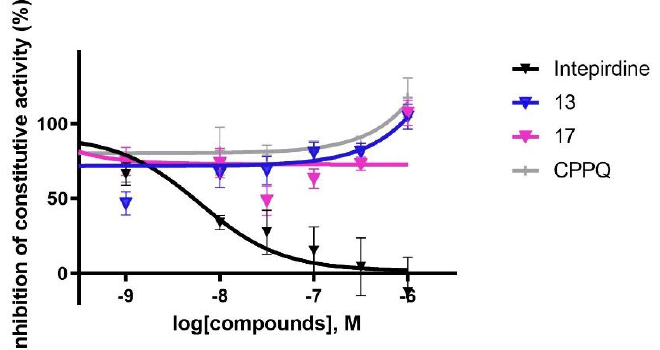
Figure 3. Influence of 13 , 17 , CPPQ, and intepirdine on 5-HT 6 R constitutive activity at Gs signaling in NG108-15 cells.